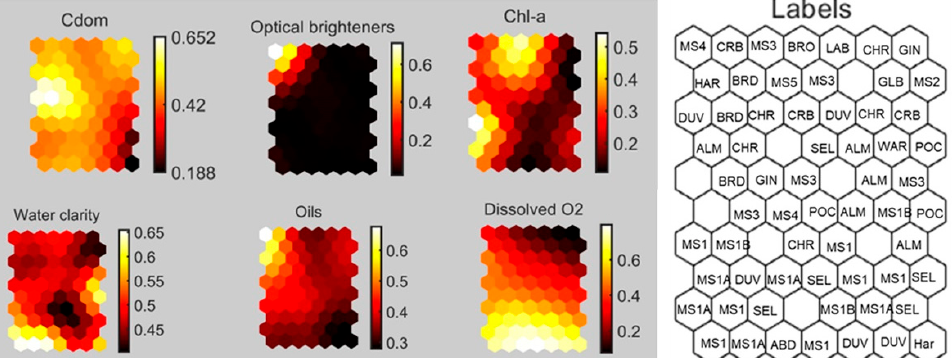
Figure 14. SOM input planes map, CDOM, O.B. Chl ‐ a , water clarity, oils, and dissolved oxygen. Station labels mapped to the SOM are located to the right in the diagram.